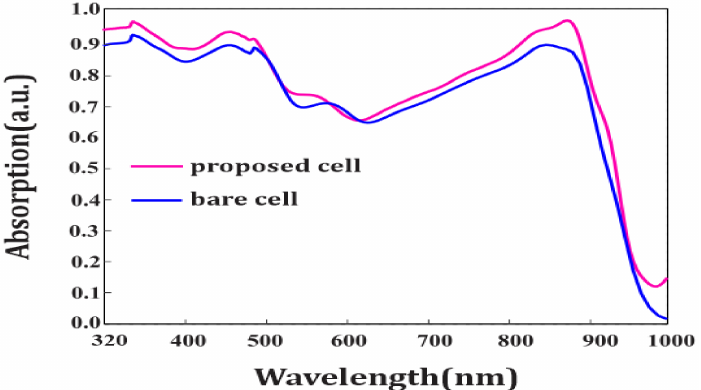
Figure 4. Absorption spectra for bare cell and proposed cell.